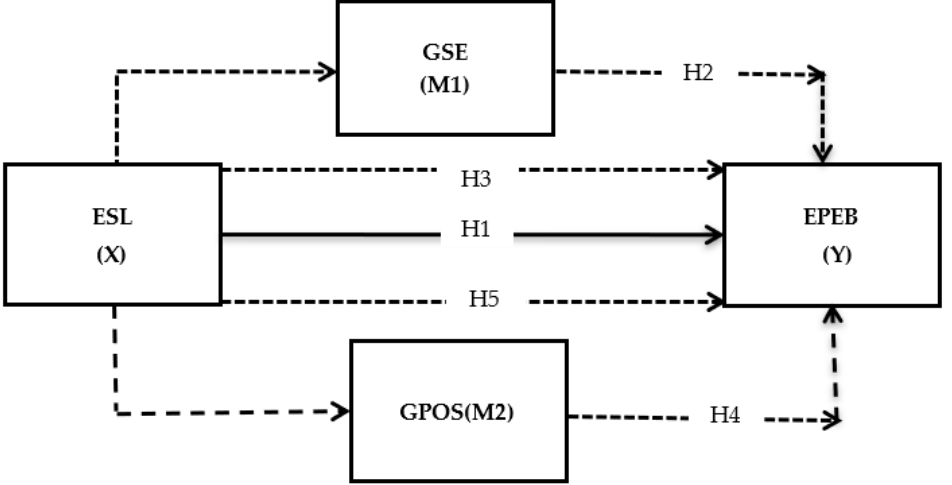
Figure 1. Theoretical framework showing different relationships. The dotted lines show the direct relationships in the presence of mediators. The bold lines show the total effect between predictor and criterion. ESL = environment-specific servant leadership, EPEB = energy-specific pro-environmental behavior, GSE = green self-efficacy, GPOS = green perceived organizational support.